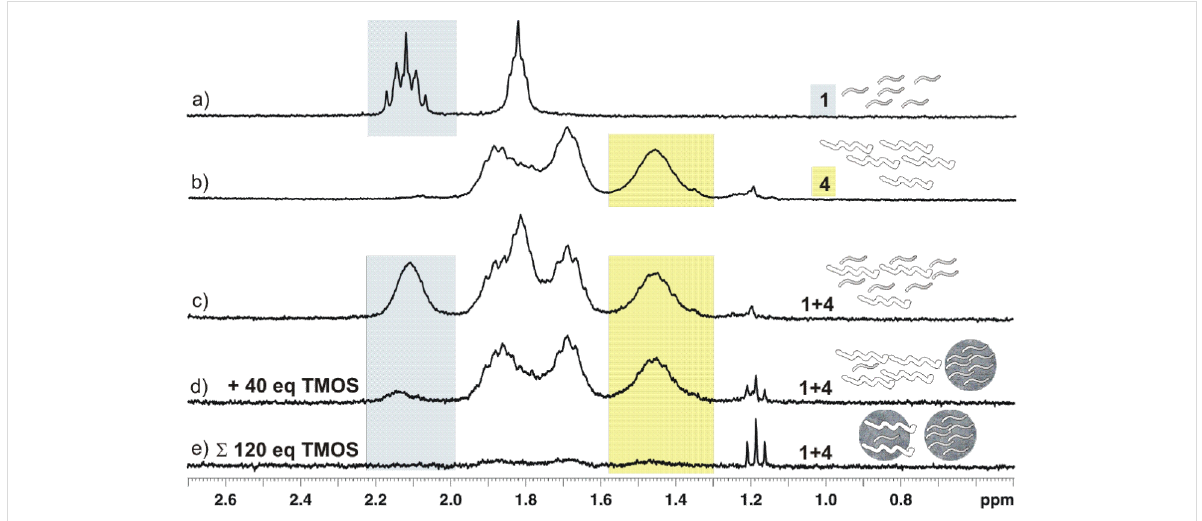
Figure 7: Expansions from the 1 H NMR spectra (300 MHz, 300 K) of 1 a) and 4 b) and the spectrum of an equimolar mixture of both c) before the ad- dition of orthosilicic acid at pH 7 together with the spectra of the stepwise addition of TMOS in d) and e). A methylene group that is only present in 1 and another that is only present in 4 are highlighted and document the stepwise precipitation of the two molecules. (Triplet at 1.19 ppm EtOH from residual tetraethyl orthoslicate (TEOS) in TMOS.) The complete 1 H NMR spectra are shown in the Figure S3, Supporting Information File